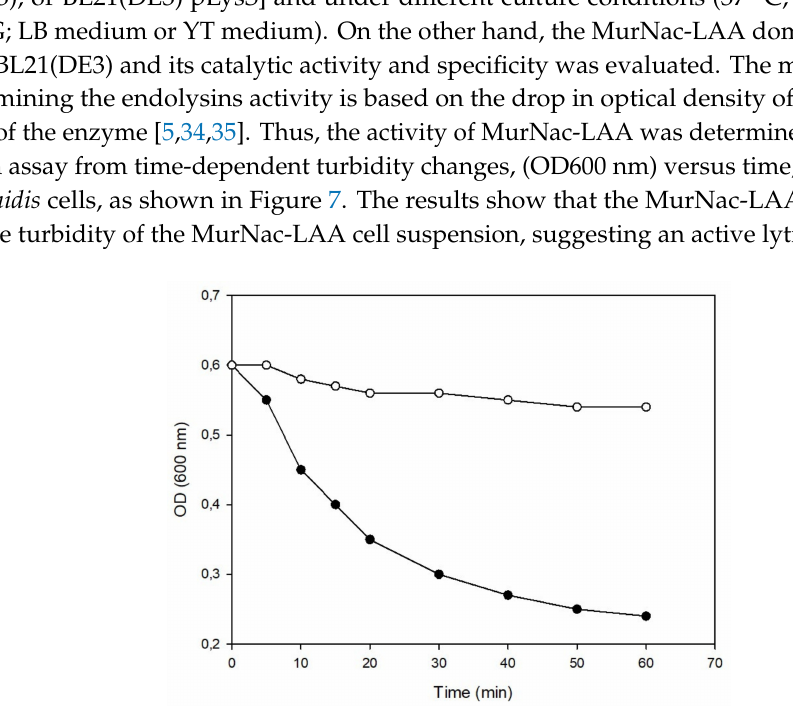
Figure7. EnzymeactivityoftherecombinantMurNac-LAAdomain. Enzymeactivitywasdemonstrated by measuring the time-dependent turbidity changes in a suspension of S. epidermidis (ATCC 12228) cells. Changes in turbidity was measured spectrophotometrically at 600 nm at regular time intervals and at a fixed temperature (25 ◦ C), using extract from recombinant E. coli BL21(DE3) cells ( • ), compared to a negative control using untransformed E. coli BL21(DE3) cells ( ). (cid:35)